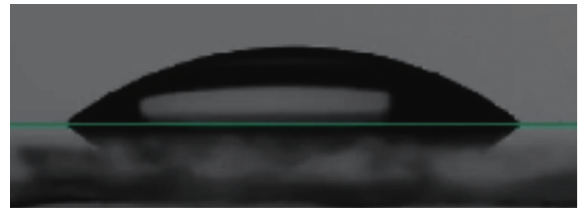
Figure 4: Baseline positioning using droplet